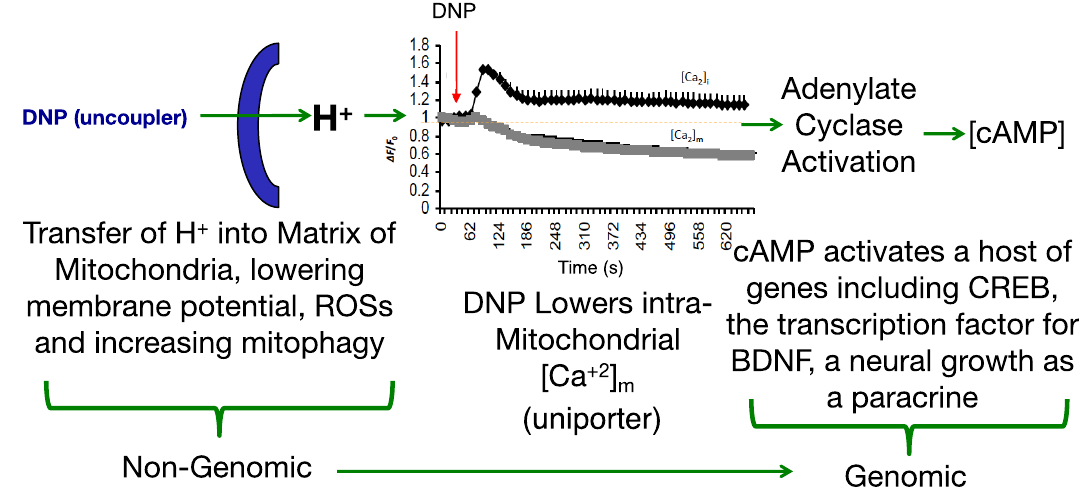
Figure 1. Non-genomic to Genomic Effects of 2,4-Dinitrophenol (DNP). The early immediate effects of DNP lower the mitochondrial membrane potential, which abolishes overt reactive oxygen species (ROS) production and subsequently closes the uniporter involved in calcium influx [28–30]. This event is considered “non-genomic” since the target is a location, the mitochondrial matrix, vs. a protein, receptor or gene. However, this effect increases cyclic adenosine monophosphate (cAMP) (2nd messenger), likely through activation of adenylate cyclase. The production of cAMP transitions the non-genomic event into a genomic event and induction of expression of a host of genes, both up-regulated and down-regulated. In particular, the DNP → cAMP → cAMP response element binding (CREB) → Brain-derived neurotrophic factor (BDNF) cascade lends itself to the possibility of increased cognition [30–32]. Calcium graph was adapted from Liu, et al. 2015 [30]. 3. ROS